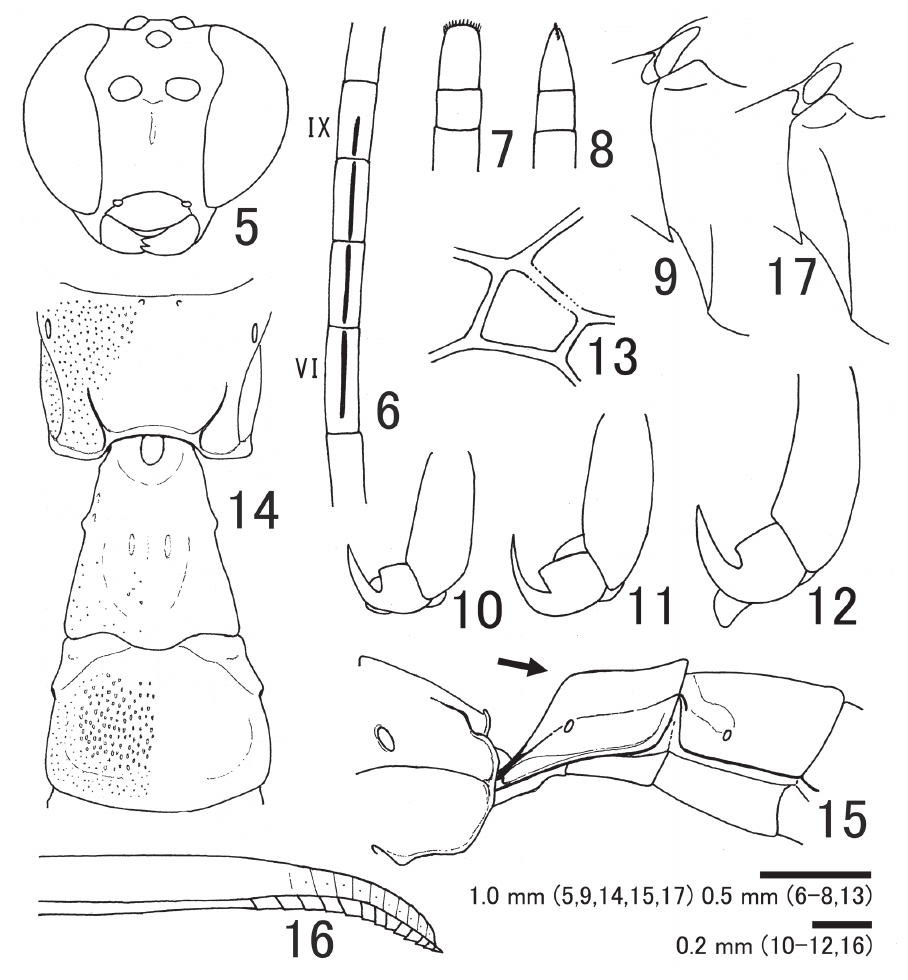
Figures 5–17. Holotypes (female) of A . cantika sp. n. ( 5 , 7–16 ) and A . taiwana Uchida ( 17 ), paratype (male) of A . cantika sp. n. ( 6 ) 5 Head, frontal view 6 left flagellum, lateral view 7 , 8 apex of flagellum, dorsal ( 7 ) and lateral ( 8 ) views 9 , 17 anterior half of mesopleuron, lateral view 10–12 left fore- ( 10 ), mid- ( 11 ) and hind ( 12 ) tarsal claw, lateral view 13 fore wing areolet 14 , 15 propodeum and metasomal tergites I and II, dorsal ( 14 ) and lateral ( 15 ) views; 16 apex of ovipositor, lateral Legs: claws of all legs with basal tooth (Figs 10–12); hind femur 3.5 times as long as deep. Wings: fore wing with vein Cu-a distad to vein Rs+M by 0.4–0.5 (HT: 0.5) times length of vein Cu-a , with rectangular areolet receiving vein 2 m-cu near apical 1/3 (Fig. 13); hind wing with distal abscissa of vein Cu 1 much closer to vein 1 A than to vein M , basal abscissa of vein Cu 1 0.5 times length of vein cu-a ; 9 (left) or 11 (right) distal hamuli. Metasoma polished, punctate; tergite I 1.1–1.2 (HT: 1.1) times as long as maxi- mum width, smooth, with pair of strong median convexities (Figs 1, 3, 14, 15), con-